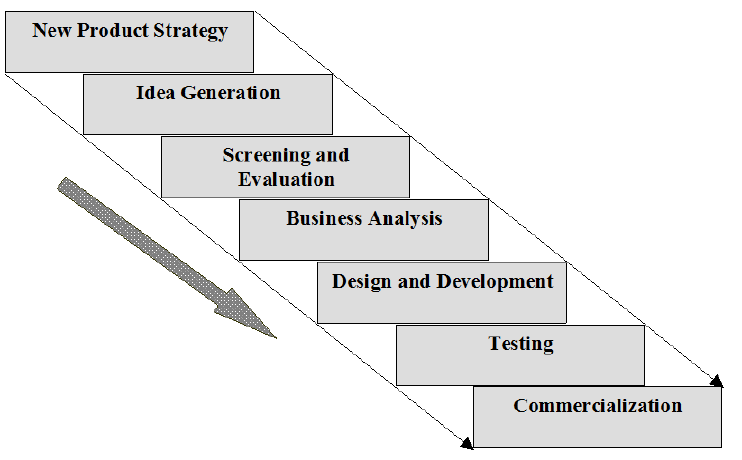
Figure 1. Stages of New Product Development (NPD) (Booz, Allen & Hamilton,